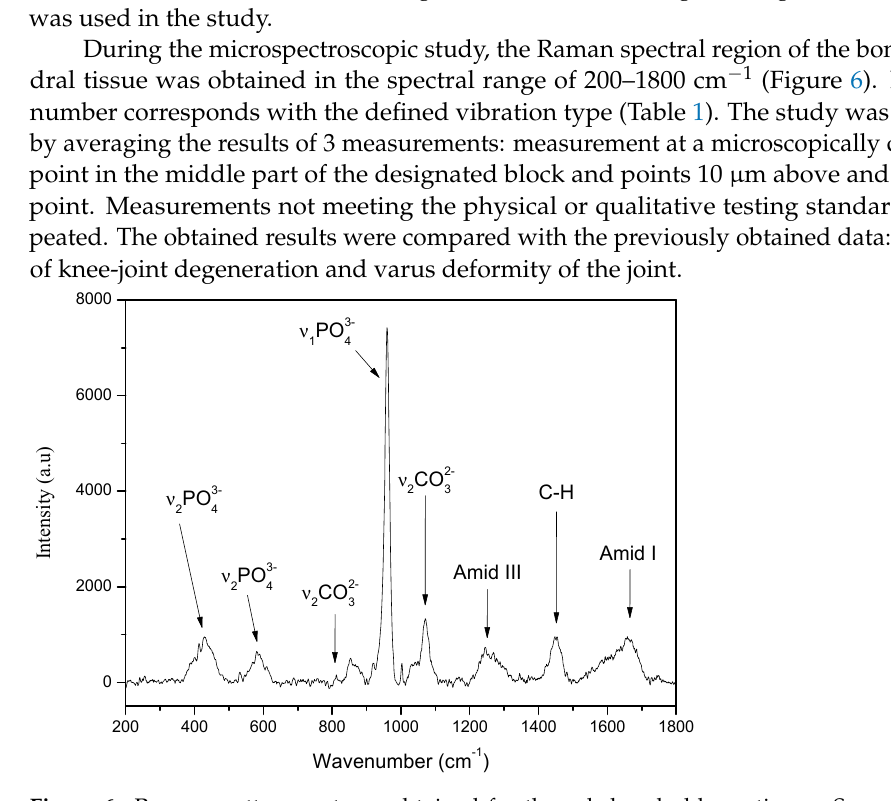
Figure 6. Raman scatter spectrum obtained for the subchondral bone tissue. Source: materials belonging to the Department of Optical Spectroscopy of the Pozna ń University of Technology. Table 1. Location of the corresponding bands in the Raman scattering spectrum.